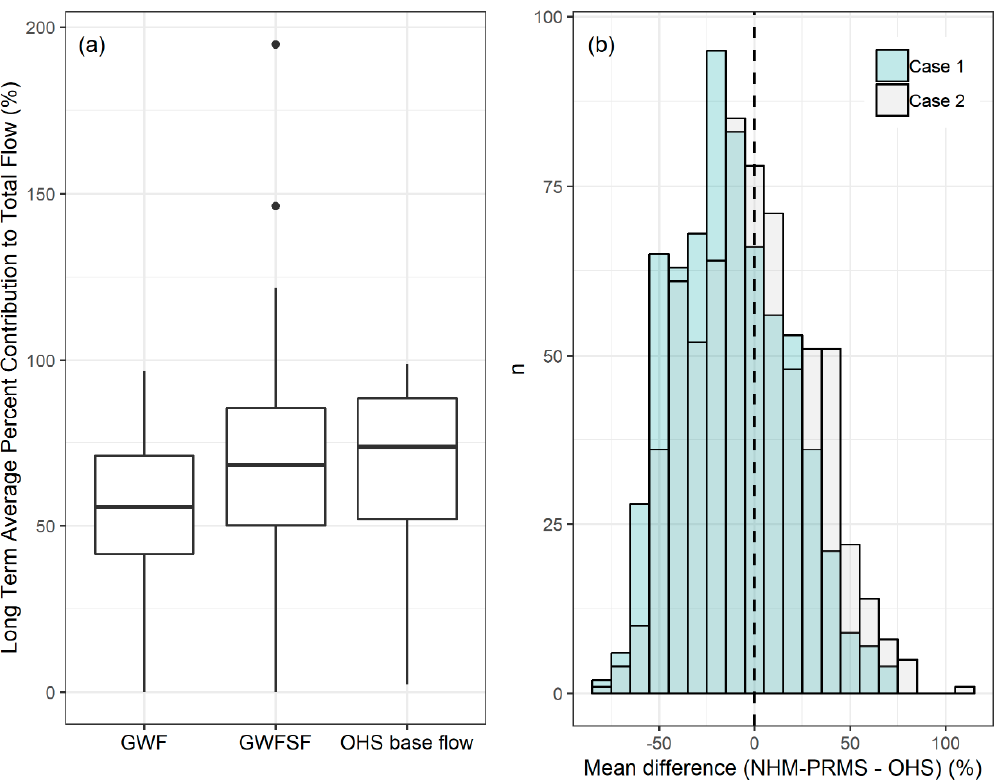
Figure 8. ( a ) Long-term average distributions of percent contribution from GWF, GWFSF, and OHS base flow to total outflow and ( b ) distributions of the mean difference between GWF and OHS base flow (case 1) and mean difference between GWFSF and OHS base flow (case 2). Instances of >100% average contribution to streams are due to the comparison of HRU-based volumes with routed-based stream segment volumes (n = 6 out of 662 sites compared).